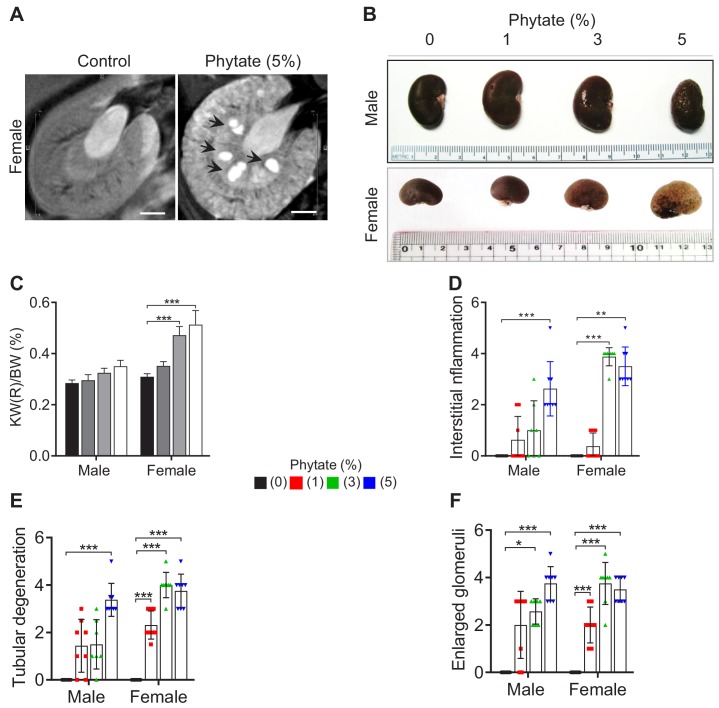
Histopathological features of the kidneys of phytate-fed rats.(A) Representative T2-weighted magnetic resonance images (MRIs) of the kidneys of female rats fed either a control or a 5% phytate diet. (B, C) Representative gross morphological features of the kidneys (B) and kidney weight (%) relative to body weight (KW/BW) (C) of rats fed control and phytate-supplemented diets. (D–F) The renal histopathological scores for interstitial inflammation (D), tubular degeneration (E), and enlarged glomeruli (F) from rats fed control and phytate-supplemented diets. All comparisons were performed by one-way ANOVA with Tukey’s post hoc multiple comparison test or the Kruskal–Wallis (D–F) test for non-parametric statistical analysis of data that did not have a normal distribution. Panels (D–F) failed the normality test, but no outliers were identified. All data are presented as the mean ± SD for each group (n = 8 per group). *, p <0.05, compared with controls.